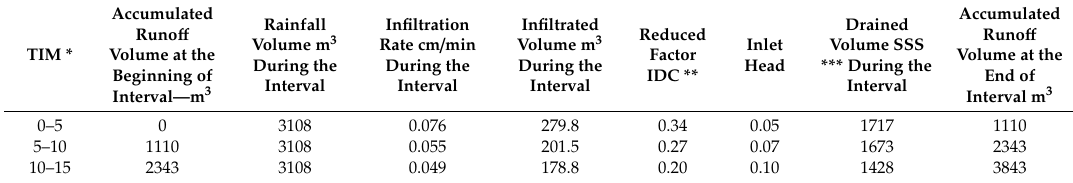
Table 2. Rainfall-runo ff model